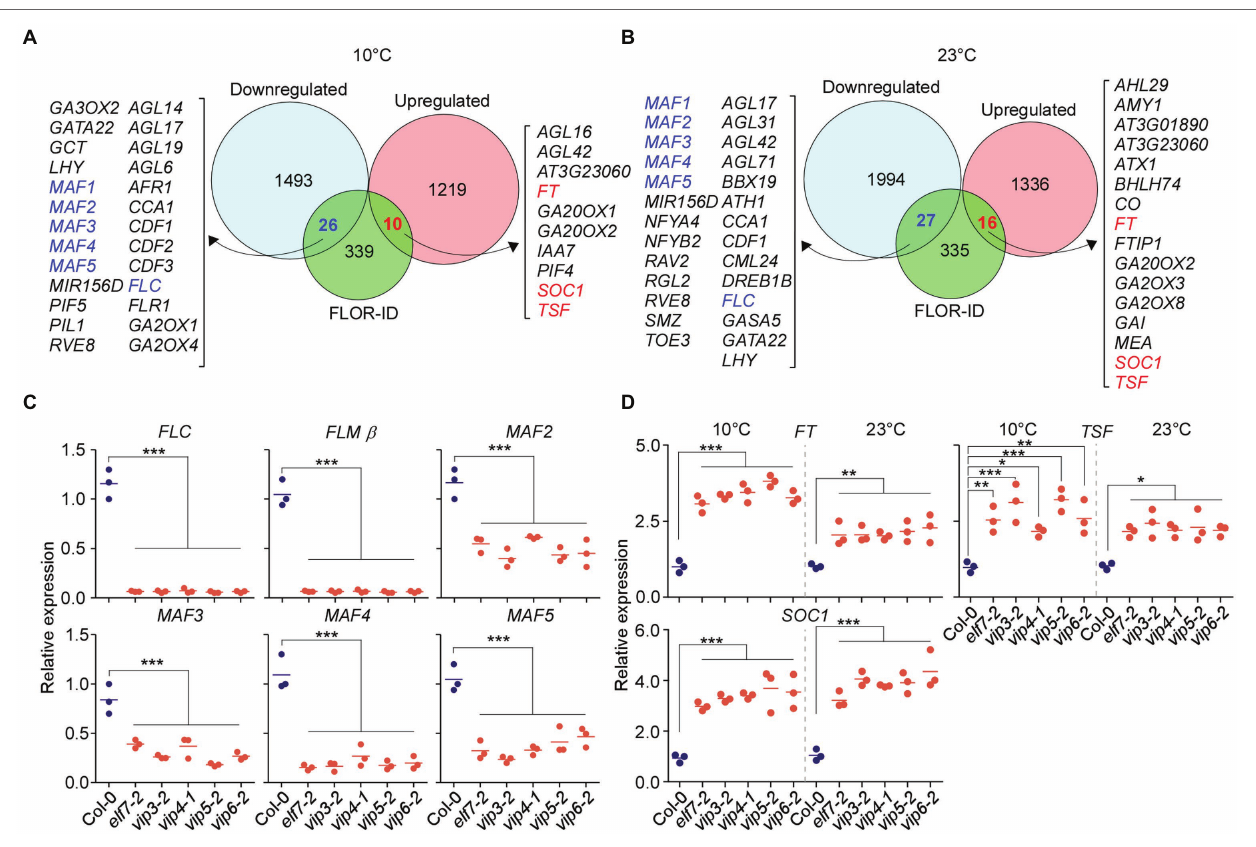
FIGURE 3 | Polymerase II–associated factor 1 complex regulates expression of FLOWERING LOCUS C ( FLC ) and the FLC -clade genes MADS AFFECTING FLOWERING1 ( MAF1 ) /FLOWERING LOCUS M ( FLM ) and MAF2–MAF5 . (A,B) Commonly downregulated and upregulated flowering genes in PAF1C-deficient mutants at 10 ° C (A) and 23 ° C (B) . (C) qPCR confirmation of downregulation of FLC and FLC -clade genes in PAF1C-deficient mutants at 10 ° C. (D) mRNA levels of FLOWERING LOCUS T ( FT ), TSF , and SUPPRESSOR OF OVEREXPRESSION OF CO1 ( SOC1 ) in PAF1C-deficient mutants at 10 and 23 ° C. One-way ANOVA followed by Dunnett’s multiple comparison tests were performed to test the statistical significance. * p < 0.05; ** p < 0.01; and *** p ≤